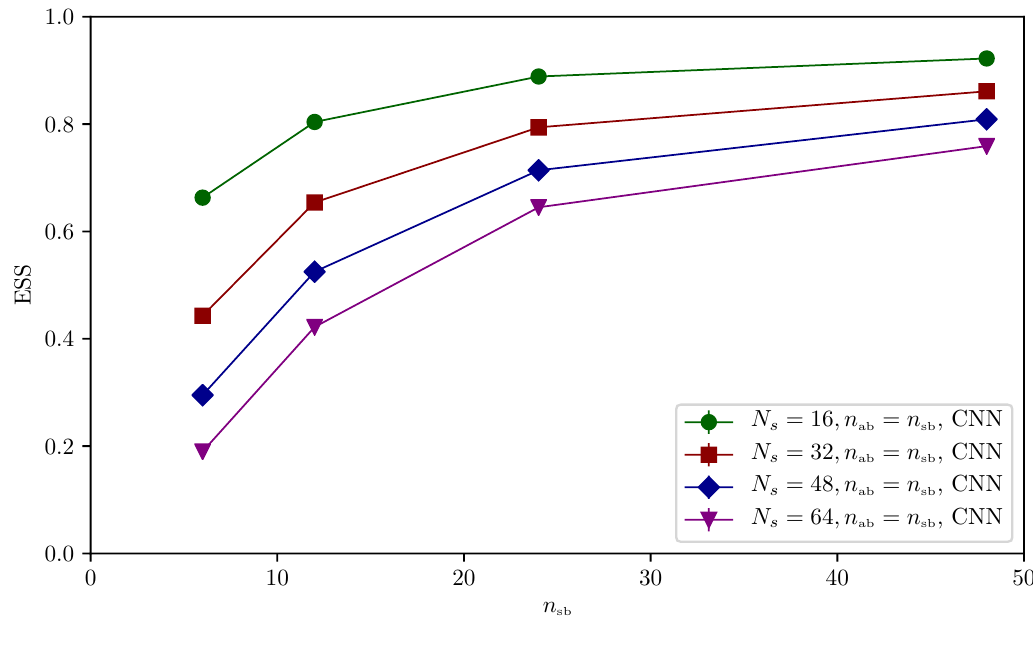
Figure 7 . ESS comparison for N s × 8 lattices between CNN-based SNFs with n sb = n ab , at κ = 0 . 2 , λ = 0 . 022